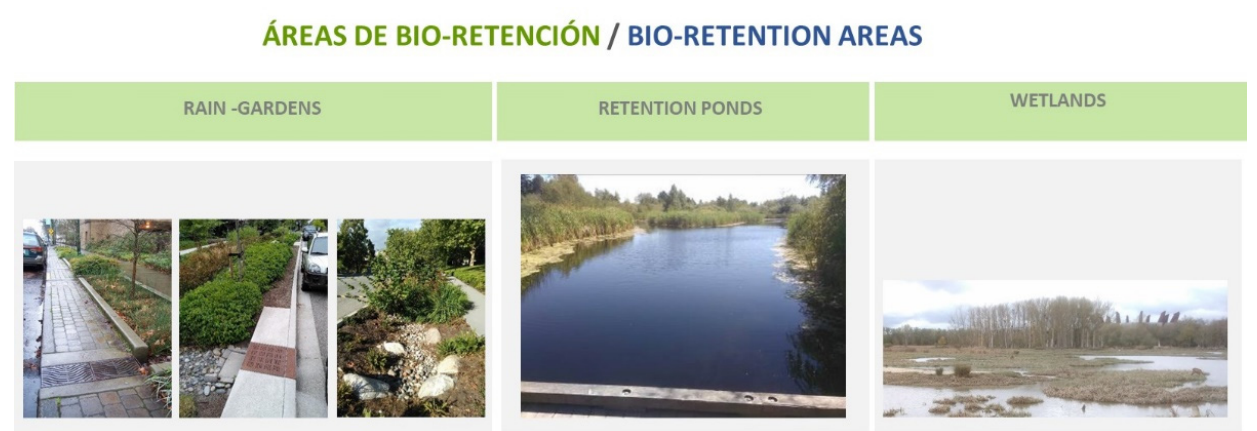
Figure A6. Types of bio ‐ retention areas (table and images by the authors).